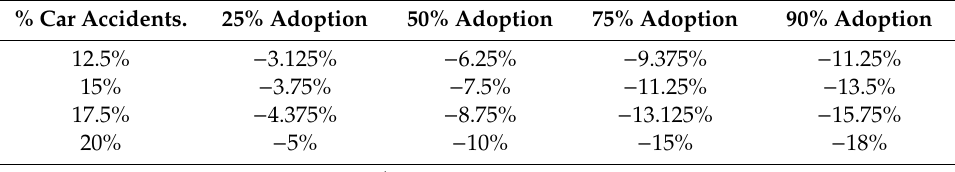
DIMINUTION in KIDNEYS 1 (Based on WHO data for 2015 in United States). % Car Accidents